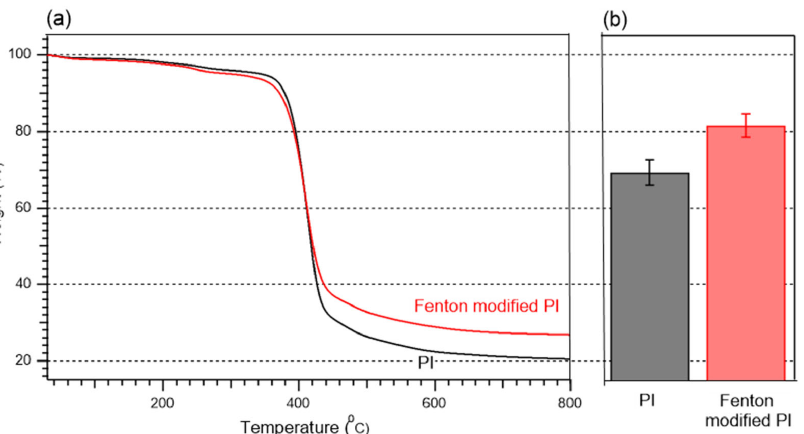
Figure 9. ( a ) TGA spectrum of pristine and modified membranes and ( b ) residual weight of pristine and Fenton ‐ modified membranes soaked in DMAC at 80 °C for 20 h. Table 2 presents a comparison of the solvents used for cross ‐ linking the PI membrane